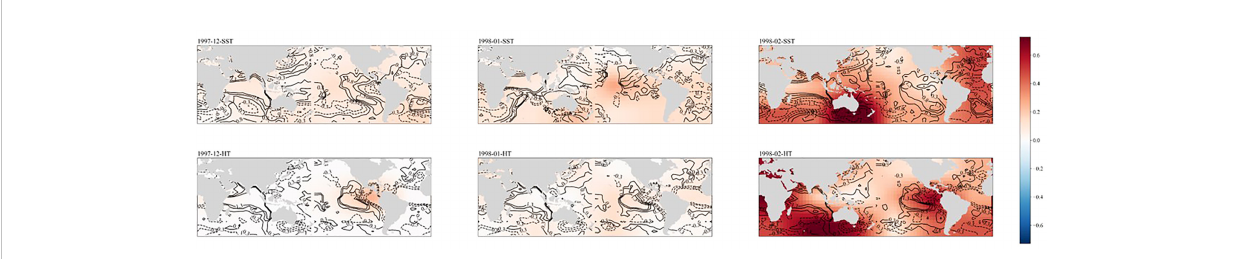
FIGURE 11 The heat map of the contribution of SSTA (in units of °C) and HCA (in units o °C) data to the prediction of the STTN model for the 1997/1998 Super El Niño event for the following 23 consecutive months (The dashed and solid line distributions indicate negative and positive values of SST or HC anomalies). The SSTA and HCA input data are from 1997-December, 1998-January, and 1998-February,